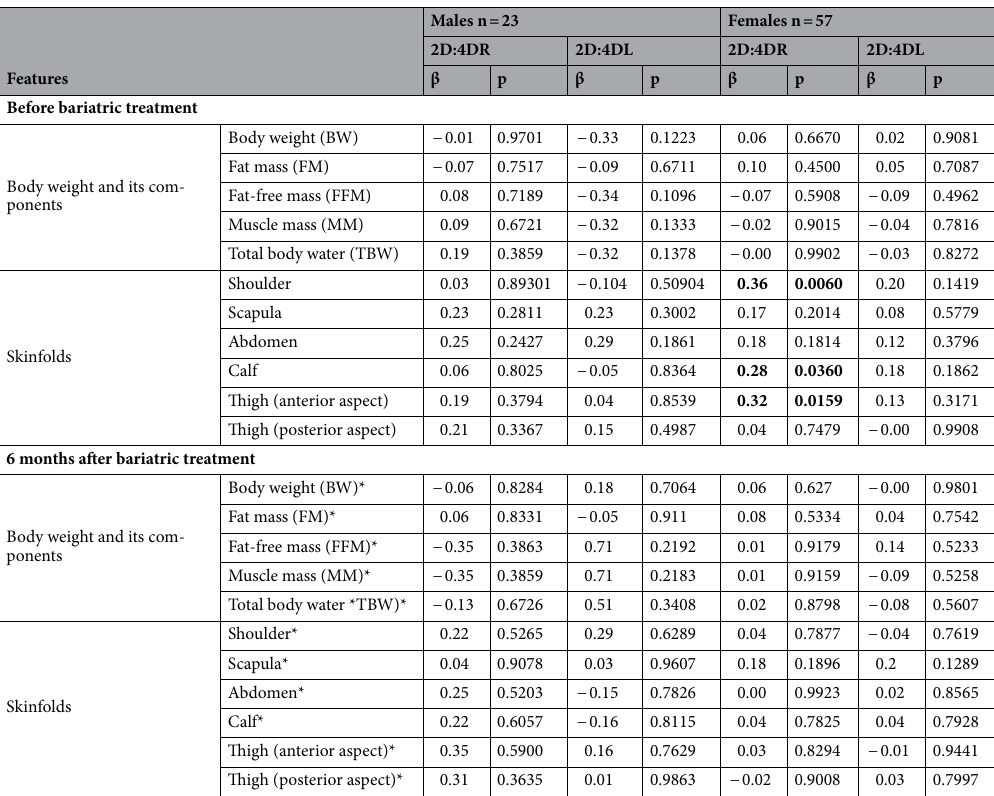
Table 6. Multiple regression analysis results concerning the relationship between the 2D:4D of the right and left hand and anthropometric characteristics before and 6 months after bariatric surgery. Significant values are in [bold]. *Adjusted for the age after Box-Cox transformation, time since surgery (in days) and type of bariatric surgery.